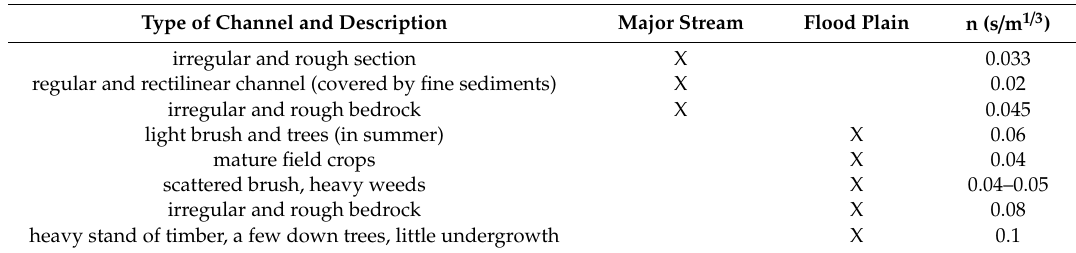
Table 3. Manning’s coe ffi cients used in the hydraulic model. Type of Channel and Description Major Stream Flood Plain n (s / m 1 / 3 )